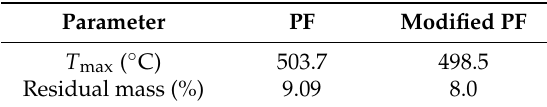
Table 3. The thermal gravimetric of the ordinary PF and modified PF (the amount of 3-pentadecyl- phenol is 15% of the total amount of